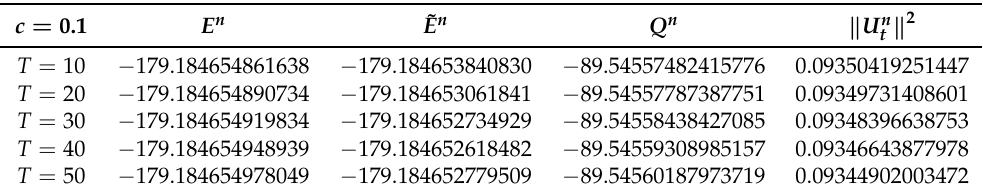
(cid:107) 2 with h = τ = c = 0.1. t